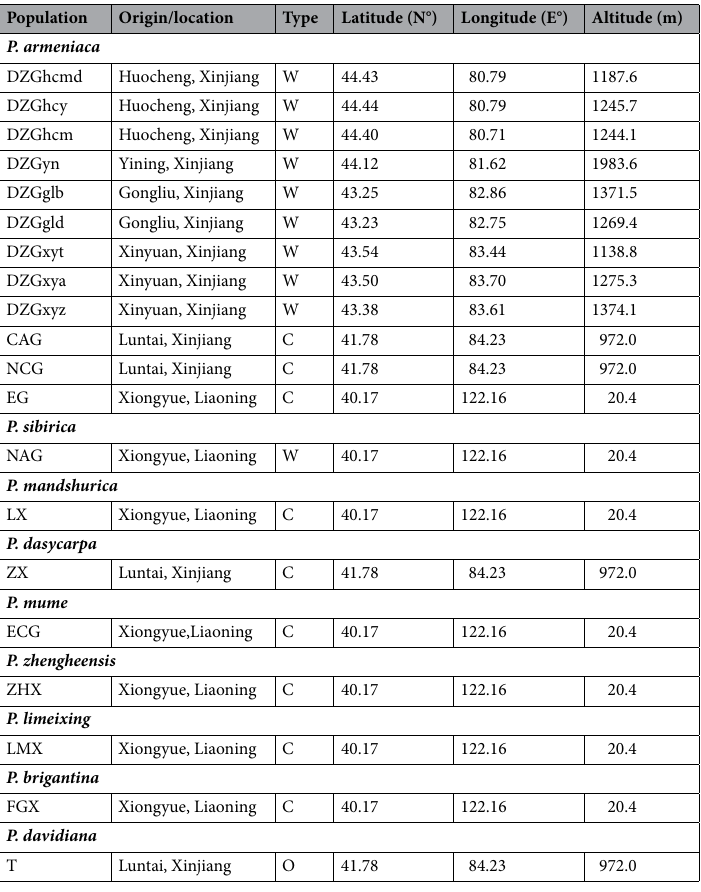
Table 1. Population code, sampling location, coordinates, altitude and types of P. armeniaca and relative species. W, wild; C, cultivars; O, out